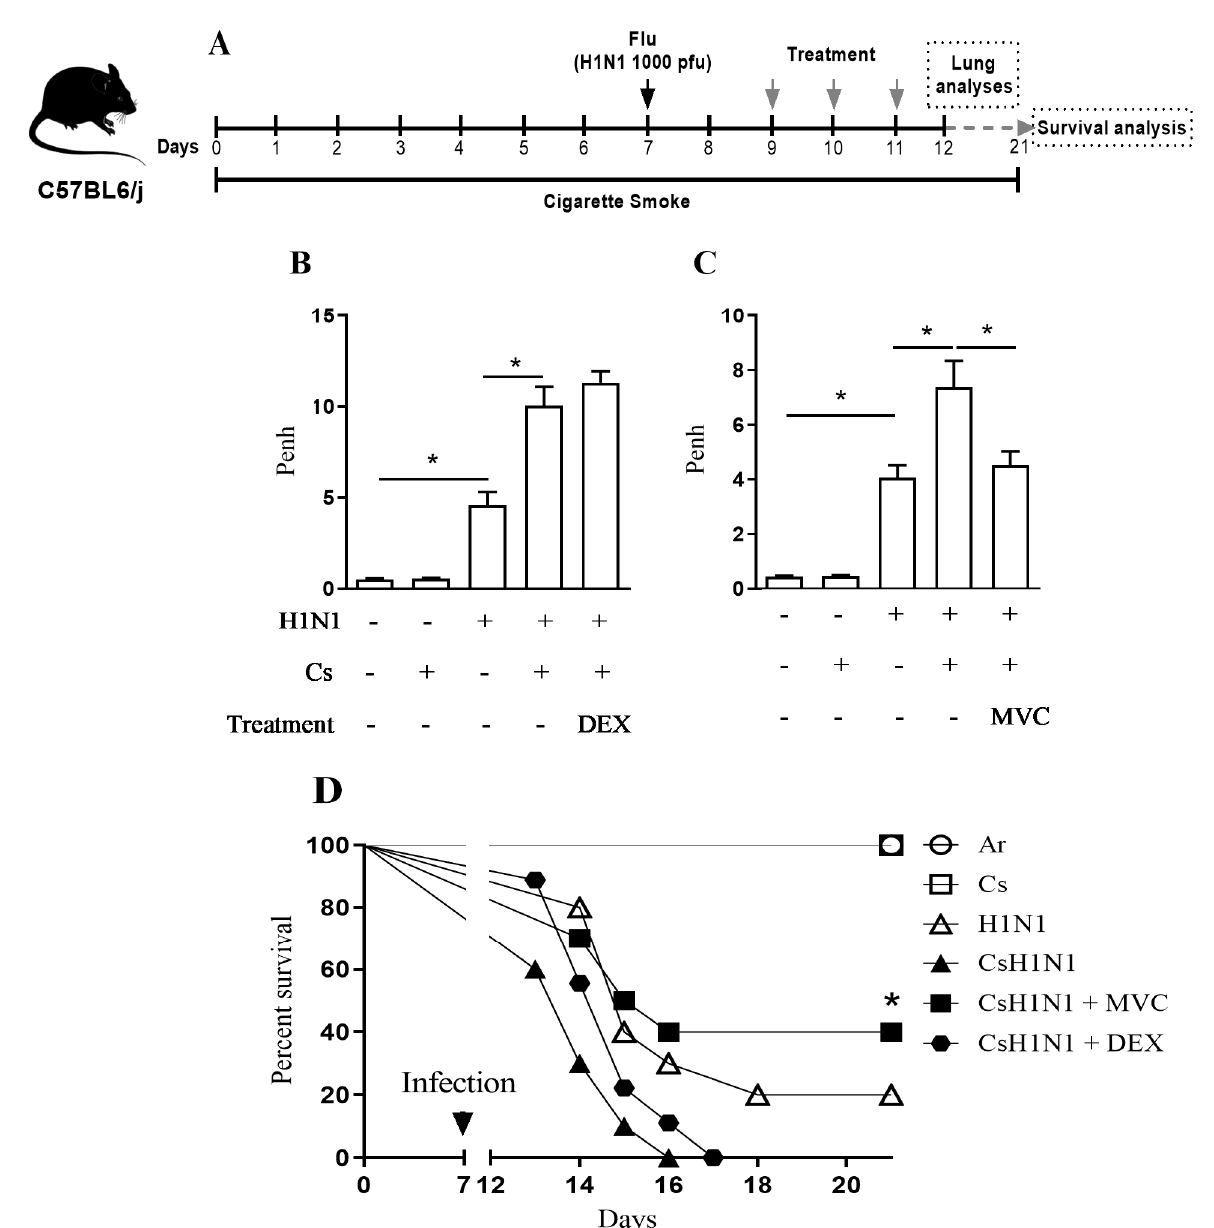
Figure 1. Maraviroc improves lung function and survival in mice, combining cigarette smoke exposure and H1N1 infection. Schematic representation of the experimental design ( A ). Effect of dexamethasone (DEX) ( B ) or Maraviroc (MVC) ( C ) on the exacerbation of enhanced pause (Penh) elevation in mice exposed to Cs and infected with influenza virus (CsH1N1) . Data are expressed as mean ± SEM from at least 6 mice per group. * for p < 0.05. Differences were statistically evaluated One-Way ANOVA with Tukey post-test. Survival proportions of the different groups of mice to day 14 after infection ( D ). n = 10 for each group. * for p < 0.05. Differences were statistically evaluated using Log-rank (Mantel–Cox) test.